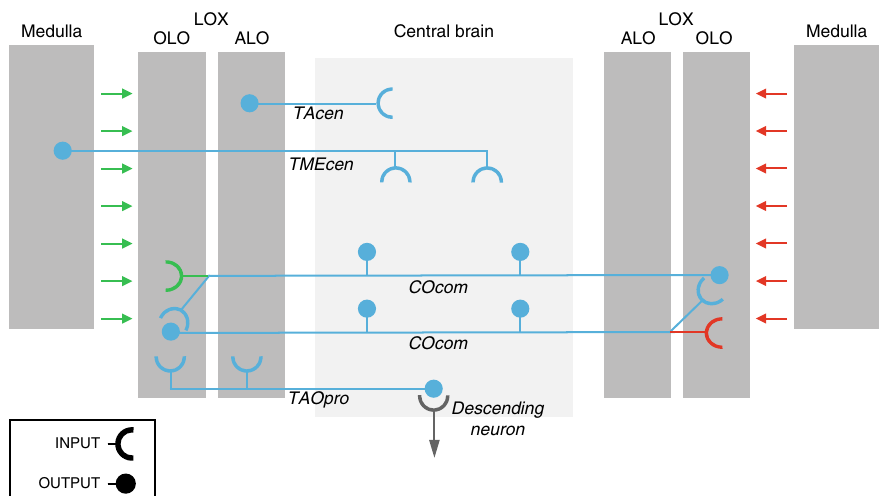
Fig. 5 Summary of neurons sensitive to binocular disparity in the praying mantis brain. Grey shaded areas represent brain regions with rami fi cations of the recorded neurons; optic lobe regions are shaded darker. Feedforward visual information fl ow from left eye is illustrated in green, from right eye in red and combined, binocular blue. Input regions are shown with semi-circles, output with disks. For clarity TAOpro, TMEcen and TAcen are shown only on left side although we envisage symmetrical neurons also on the right, and only those parts of the lobula complex that harbour neuron rami fi cations are shown. LOX lobula complex, ALO anterior lobe of the LOX, OLO outer lobe of the LOX, COcom commissural columnar neuron of the outer lobes, TAcen centrifugal tangential neuron of the anterior lobe, TAOpro tangential projection neuron of the anterior and outer lobes, TMEcen centrifugal tangential neuron of the